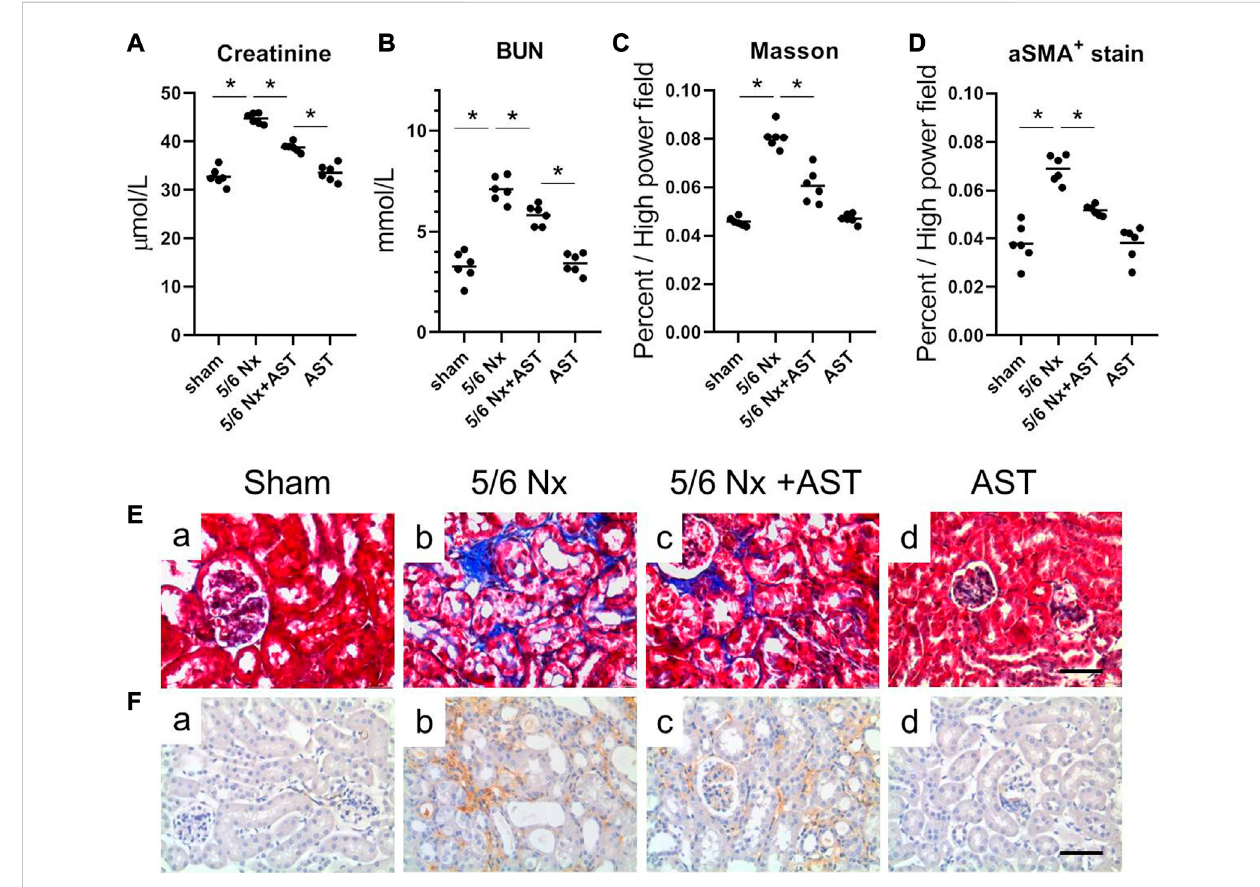
FIGURE 4 AST protected kidney against 5/6-induced injury. The serum samples were collected for the measurements of (A) creatinine, (B) BUN. (C,D) Quantitativeanalysisofthe (C) fi brosispositiveareaand (D) aSMApositiveareaperhighpower fi eld. (E,F) RepresentativeimagesshowingMassonstaining and immunostaining for aSMA in the renal sections from (a) sham, (b) 5/6 Nx, (c) 5/6 Nx + AST and (d) AST groups (scale bar 100 μ